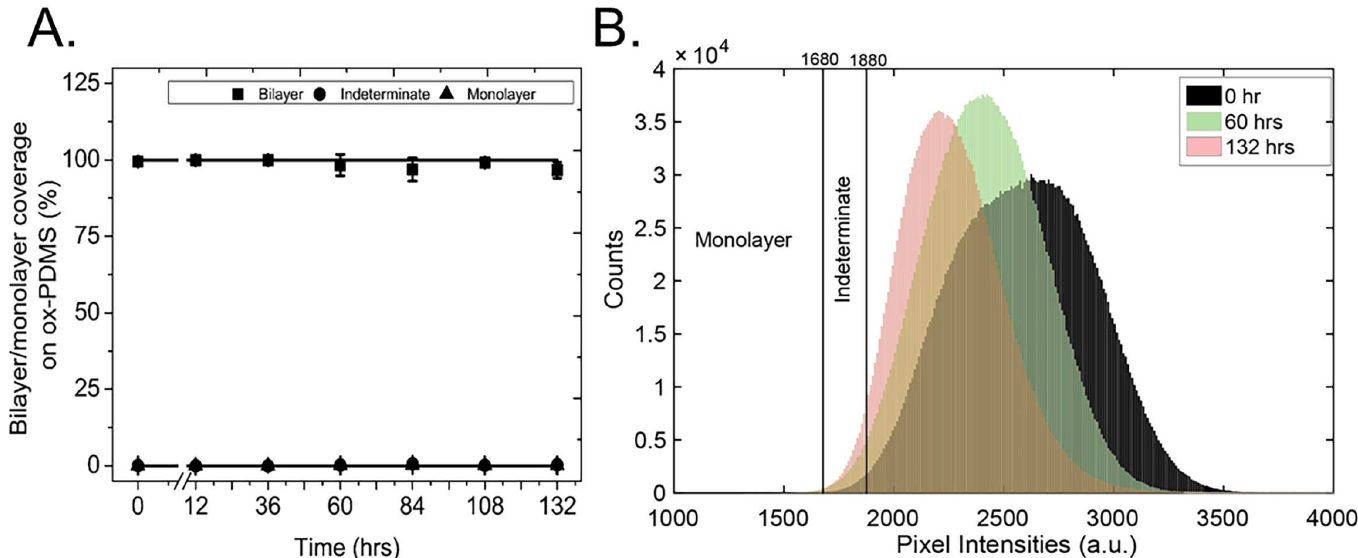
Fig 5. Quantification of the evolution of lipid bilayers on ox-PDMS as a function of time. A) The normalizedarea fraction of pixels with intensities consistent with lipid bilayersare represented by solid squares( ■ ), the normalized area fraction of pixels with intensities consistent with lipid monolayers are representedby solid triangles( ▲ ), and the normalizedarea fraction of pixels with indeterminate intensities are representedby solid circles ( ● ). Standard deviations of the mean are representedby the correspondingerror bars. The area fraction of bilayer was close to 100 percent for the durationof the 132-hour experiment. B) Plot of the histogram of pixel intensities (from N = 10 images at each time point) of lipid layers on ox-PDMS at 0 hours, 60 hours, and 132 hours after preparation. The peak of the distribution shifts with time signifyingthat the layer as a wholebecomes less bright. The distributions show a longerright tail. The combination of movement of the peak of the distribution towards lower values and the development of a right tail should result in regionsthat are brighter when comparedto the background, i.e. the mottled appearance of the layer. Note however,that the majority of pixels had intensities consistent with bilayers. The numberof pixels classifiedas indeterminate increasesslightly, and none of the pixels had intensities consistent with